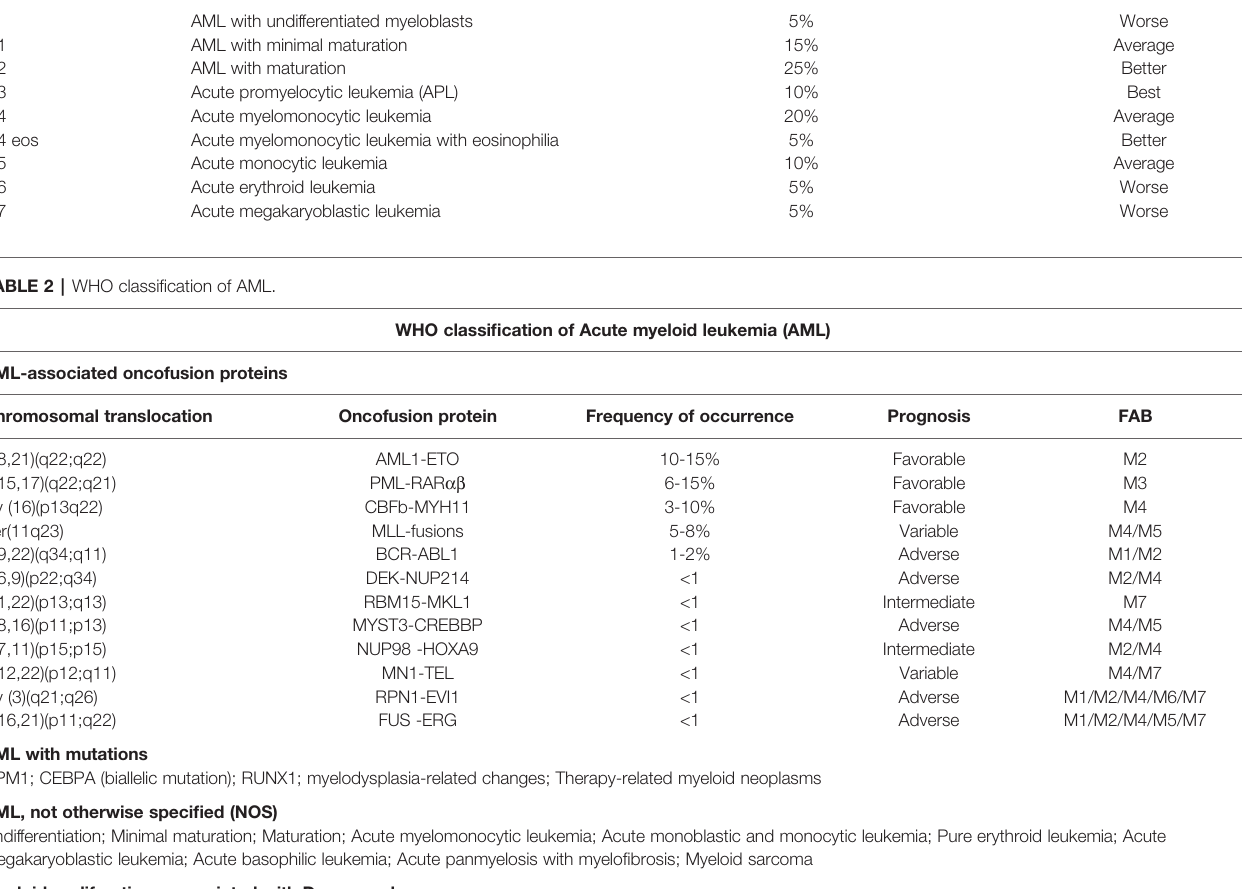
TABLE 1 | FAB subtype of AML.